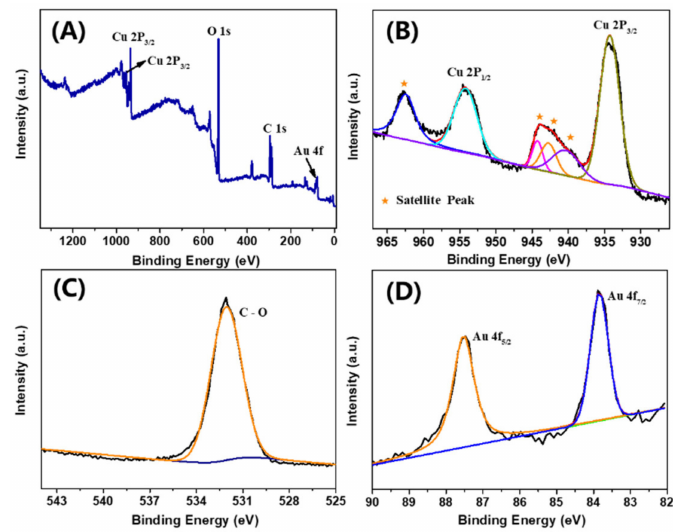
Figure 3. XPS spectra of Au@Cu(OH) 2 / CFC; ( A ) full spectrum survey; ( B ) Cu 2P; ( C ) O 1s; ( D ) Au